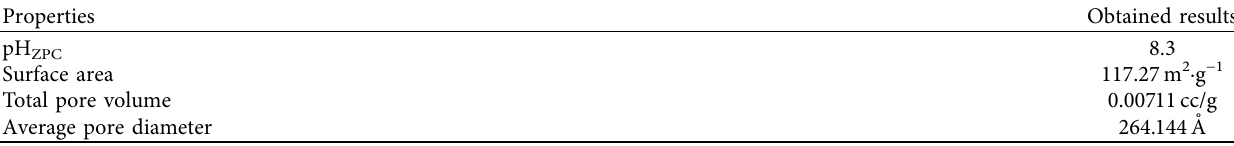
Table 1: Results of pH ZPC and BET surface analyzer of the sorbent used in this work.